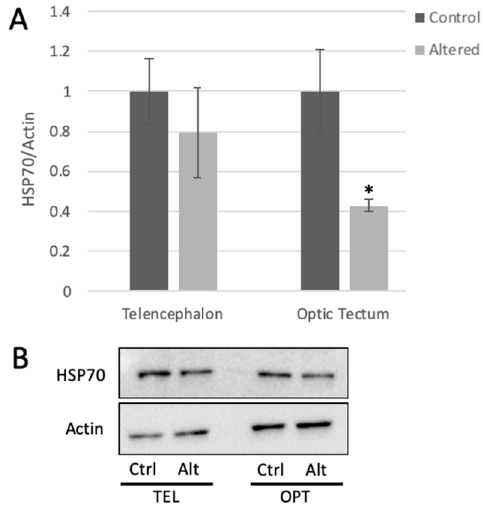
Figure 2. Light cycle alteration significantly decreases HSP70 expression in the optic tectum. ( A ) HSP70 expression measured in the telencephalon and optic tectum from control and light-altered fish. HSP70 protein levels in control samples were set to 1.00. HSP70 levels were normalized to actin. Error bars represent SEM. * p = 0.0212, Student’s t -test with 95% CI, t = 2.7286, n = 6. ( B ) Representative Western blot images.